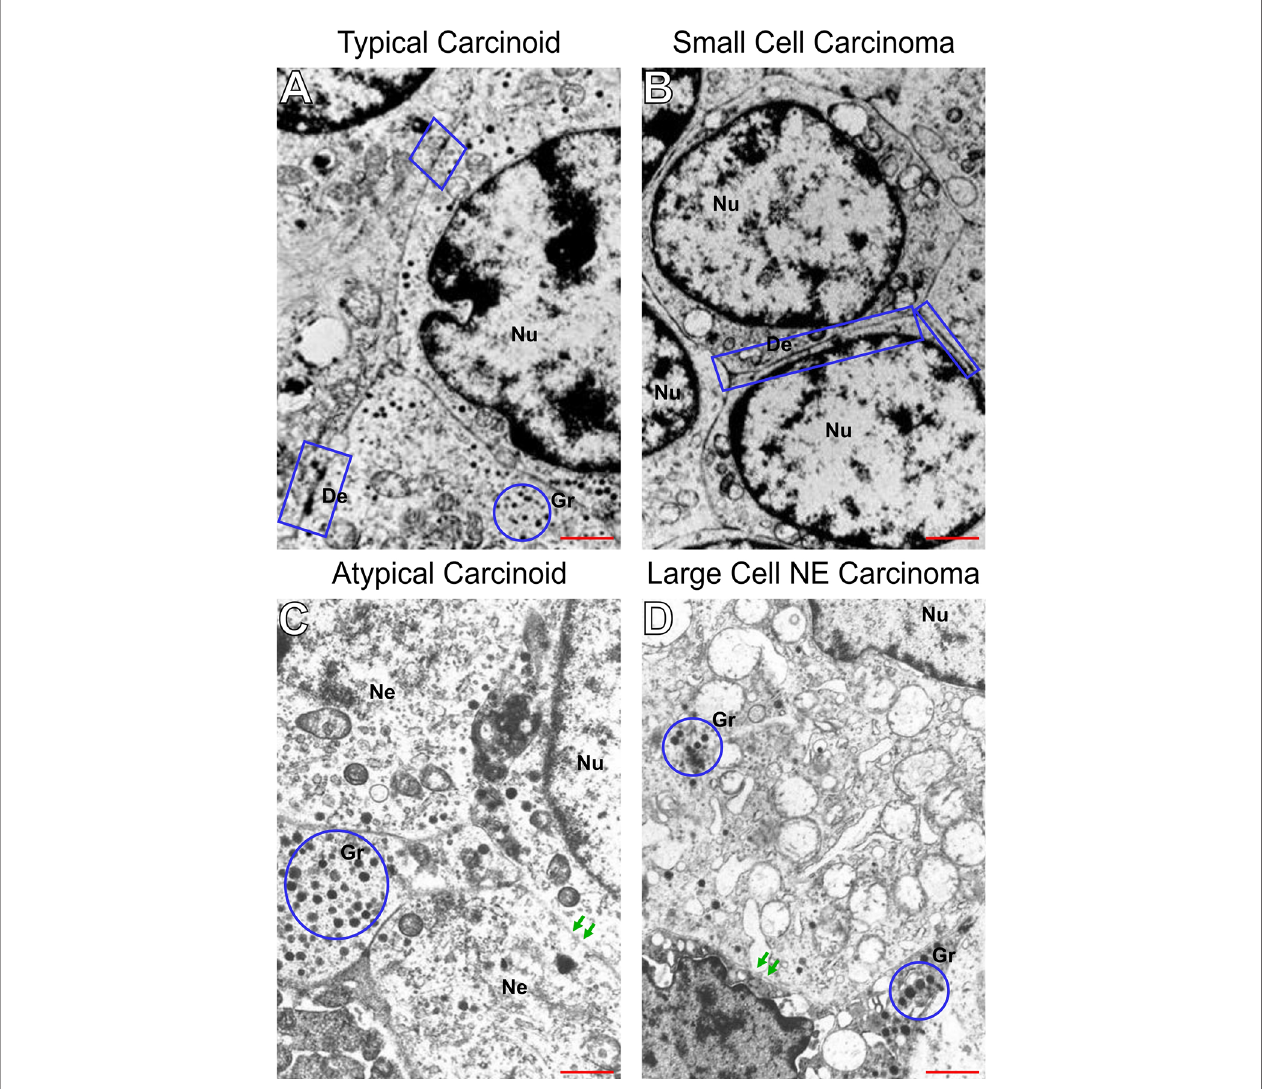
FIGURE 4 | Disruption of intercellular junctional complexes of PNENs cells and enhanced breakdown of the basement membrane. Transmission electron micrographs of PNENs cells in typical carcinoid (A) , small cell lung carcinoma (B) , atypical carcinoid (C) , and large cell neuroendocrine carcinoma (D) . Ultrastructural, the TC and SCLC present nucleus with condensed chromatin on the periphery, whereas in AC and LCNEC the nucleus are more vesiculous with sparse distribution of chromatin. The neuroendocrine origin of the four subgroups is evident by different amounts of the NE granules (blue circles) inside of cytoplasmic processes or dispersed in the cytoplasm. In SCLC, the tumor cells were loosely dissociated with each other through tenues desmosomes compared to TC (the electron-dense materials at the lateral side, blue circle). Note that the intercellular junctional complex are not prominent in SCLC compared to TC, suggesting abnormal levels of desmocolin. In contrast, diminishing of electron-dense materials, indicating disruptions of intercellular junctional complexes, and enhanced breakdown of the basement membrane indicating the opening of cell-cell contacts in AC and LCNEC (red arrows). The micrographs are representative PNENs sections from 24 patients. Scale bars: 1 mm. De, desmosomes; Nu, nucleus; Gr, granules; Ne,